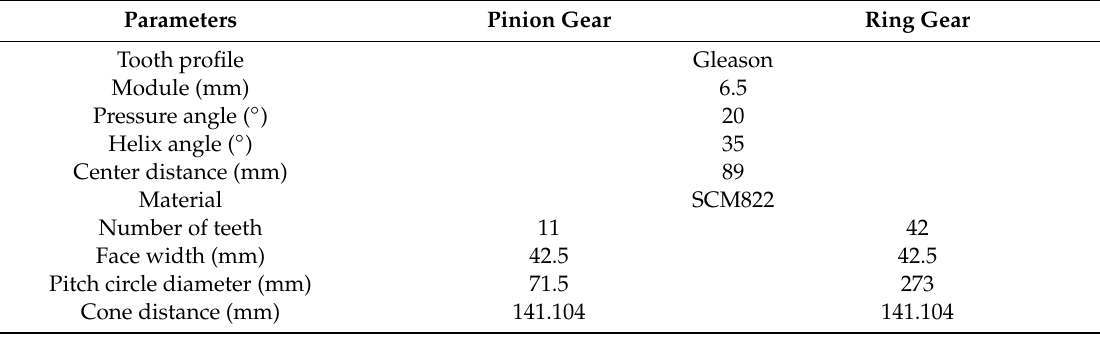
Table 2. Specifications of spiral bevel gear used in this study.